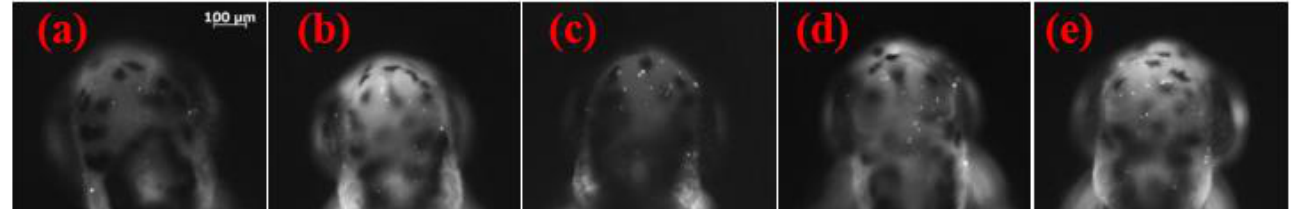
Figure 1. Effect of different ethanol concentrations on the brain cells of zebrafish embryos. Twenty-four dpf zebrafish were exposed to different concentrations of ethanol for 24 h: ( a ) control; ( b ) 0.2% ethanol; ( c ) 0.4% ethanol; ( d ) 0.8% ethanol; ( e ) 1% ethanol. Photomicrographs were taken from embryos at 48 hpf. Dorsal view, anterior to top.